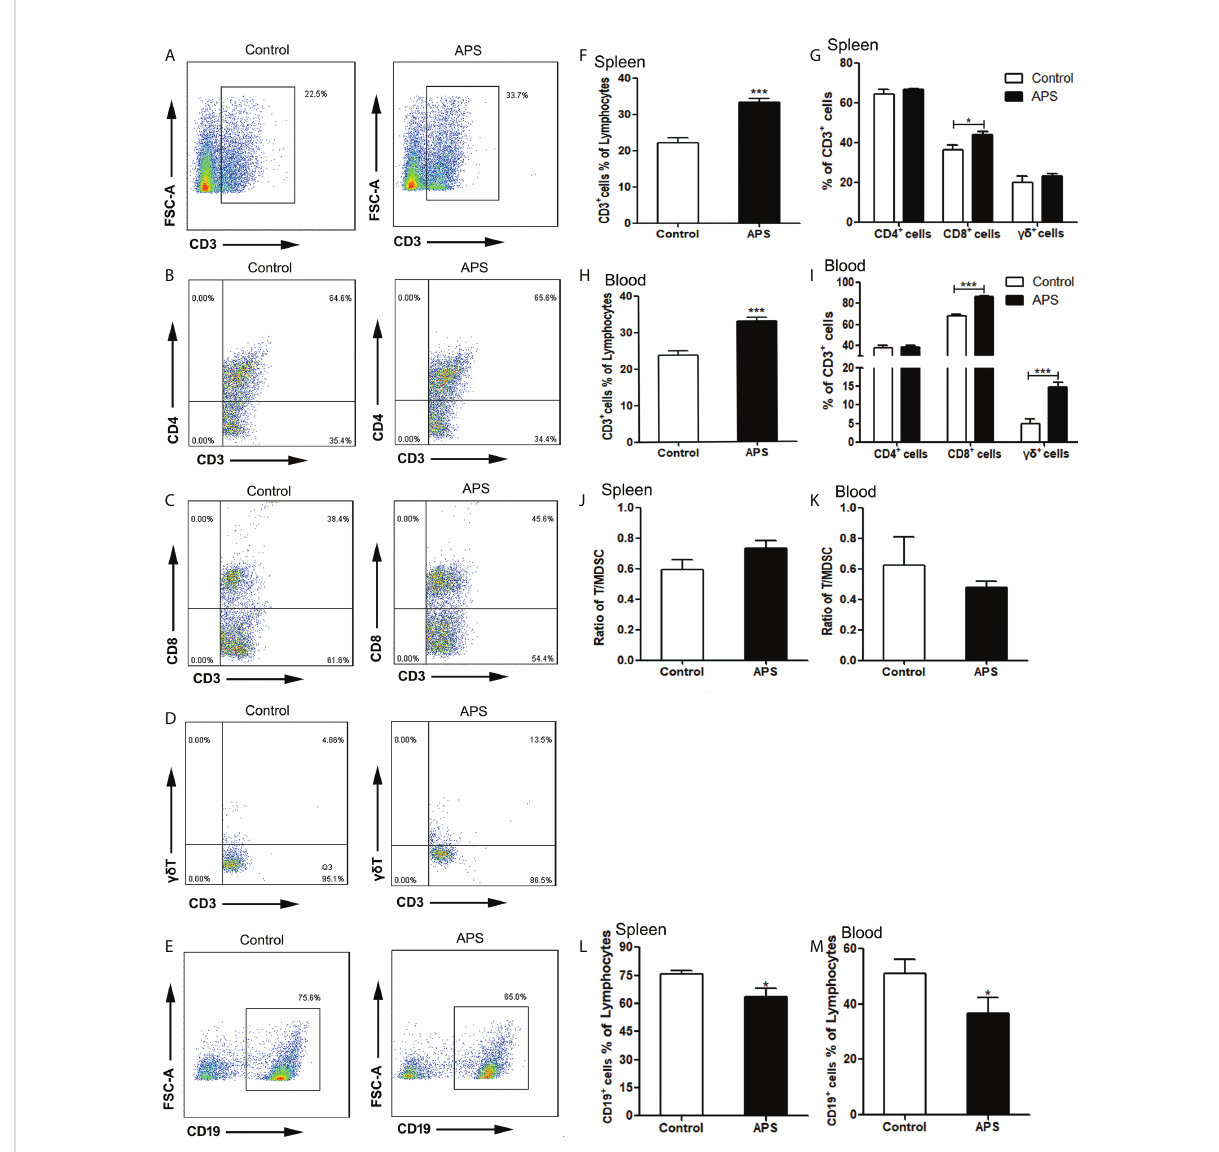
FIGURE 5 The percentages of T cells, T subpopulations and B cells in the spleen and peripheral blood. The spleen and peripheral blood were collected from the Control/APS-treated mice. Single-cell suspensions were generated, and the cells were immune-stained for CD3, CD8, CD4 and gd . (A – E) One representative result from each experiment is shown. The percentages of CD3 + cells among the lymphocytes in spleen (F) and blood (H) (***p<0.001). The percentages of CD3 + CD4 + T, CD3 + CD8 + T cells and gd + T cells among the CD3 + T population from lymphocytes in spleen (G) and blood (I) (***p<0.001, *p<0.05).The ratio of T/MDSC in splenocytes (J) and blood (K) . The percentages of CD19 + cells among the lymphocytes from splenocytes (L) and blood (M) (*p<0.05). n=6, Data are expressed by mean ±